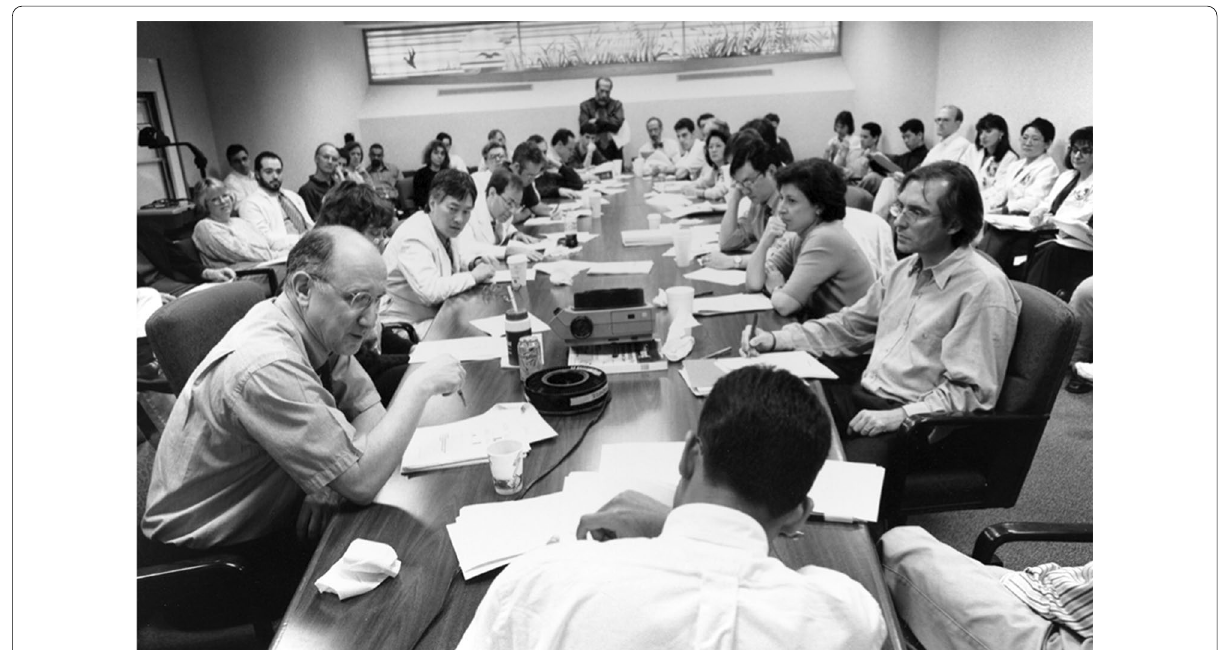
Fig. 4 In weekly laboratory meetings (this one in 1998) of all members of my group including scientists, clinical fellows, technicians, students and nurses. Fellows presented their ongoing research designed to receive input and keep all up-to-date on clinical and laboratory efforts